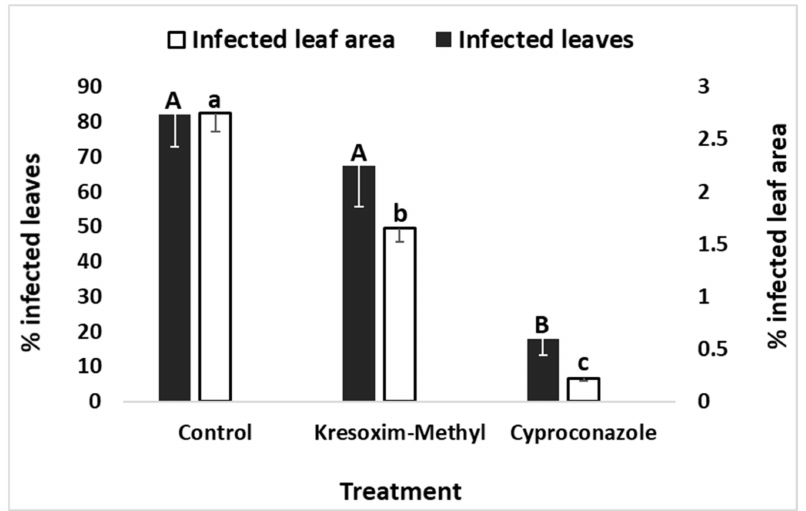
Figure 7. Efficacy of kresoxim-methyl at 0.015% ( w/v ) and cyproconazole at 0.03% ( v/v ) against apple scab in field grown Anna trees, Kadesh (Upper Galilee), 2017. Bars represent the standard error of the mean. Different letters on the bars indicate significant differences ( p < 0.05) according to Fisher’s LSD K-ratio t -test.